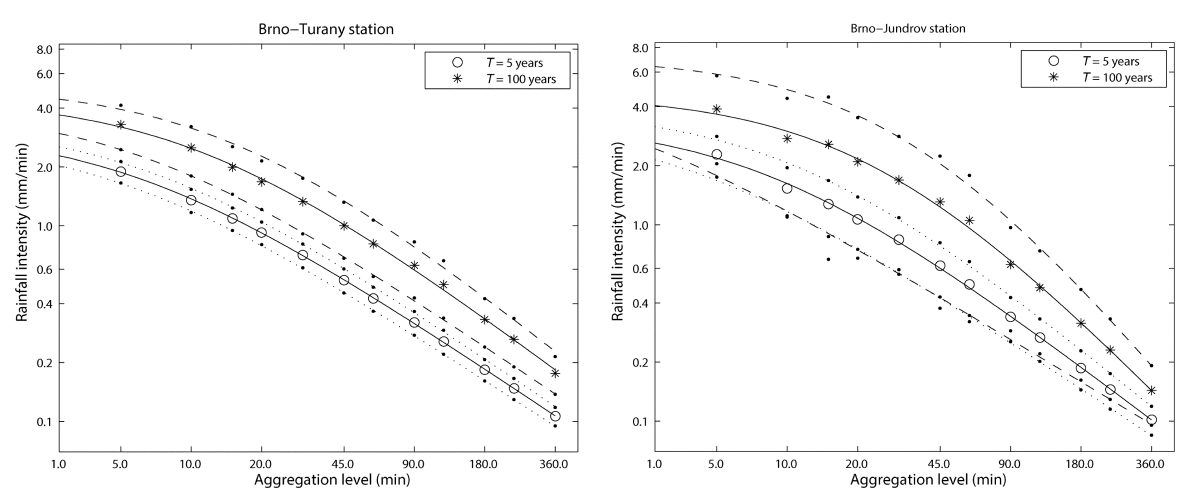
Fig. 5. IDF curves with the logarithmic scale on both axes; return period T . The 95% confidence intervals are traced with dotted ( T = 5) and/or dashed ( T = 100) lines.